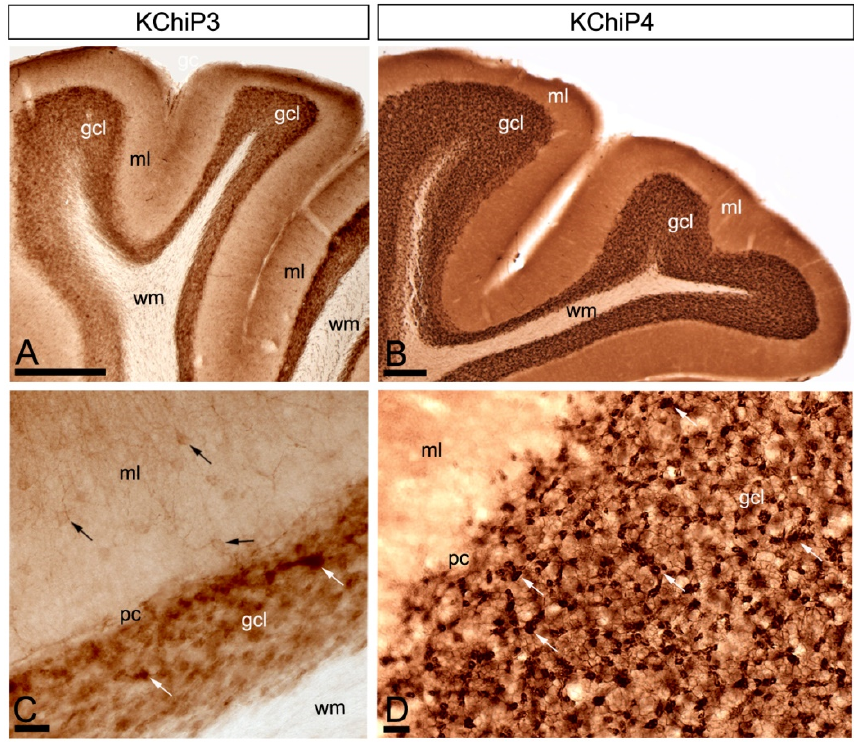
Figure 1. Regional and cellular distribution of Kv channel interacting proteins (KChIPs) subunits KChIP3 and KChIP4 in the cerebellum. ( A – D ) Immunoreactivity for KChIP3 and KChIP4 in the cerebellar cortex using a pre-embedding immunoperoxidase method at the light microscopic level. Parasagittal photomicrographs of the cerebellar cortex. Immunoreactivity for both KChIP3 and KChIP4 was widely distributed in the cerebellar cortex with mostly overlapping labelling patterns. Although with some di ff erences in intensity of labelling, strong immunoreactivity for KChIP3 and KChIP4 was found in the granule cell layer (gcl) and weaker in the molecular layer (ml) and the white matter (wm) was devoid of any staining. In the molecular layer, KChIP3 and KChIP4 was mostly neuropilar and KChIP3 labelling was also detected in cell bodies and dendrites of stellate and basket cells (black arrows). In the granule cell layer, KChIP3 and KChIP4 particularly concentrated in glomeruli (white arrows) and surrounding GCs. Scale bars: A , 50 µm; B , 100 µm; C , D , 25 µm.